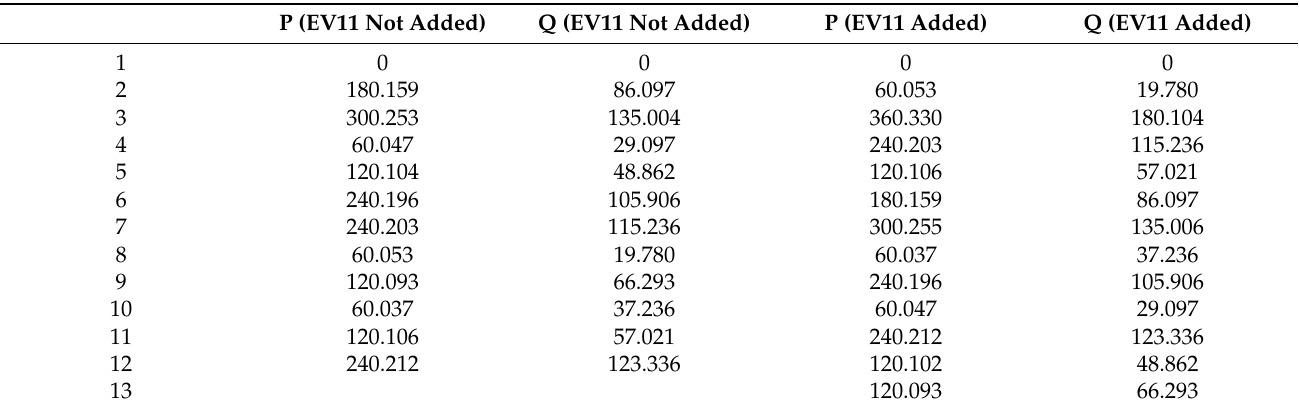
Table 2. K -means cluster